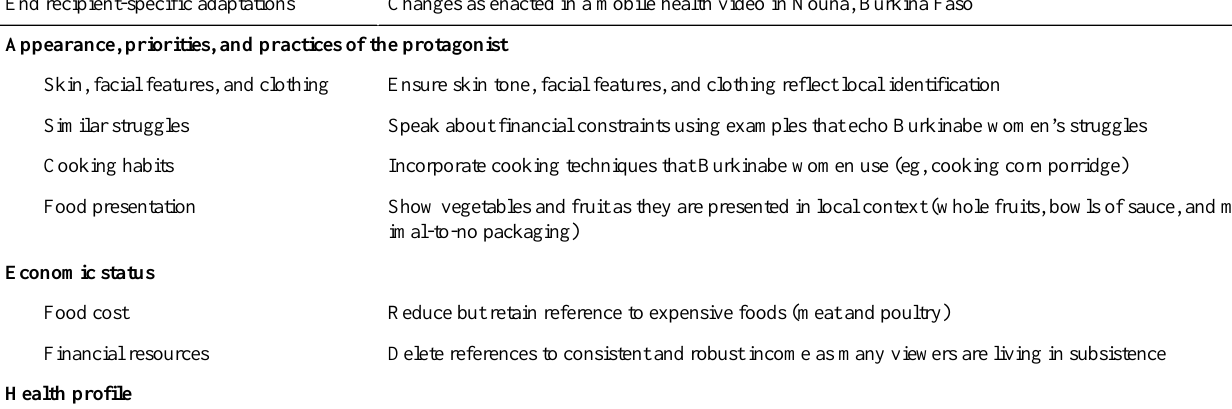
Table 6. Video adaptations: end recipient specific. Appearance, priorities, and practices of the protagonist